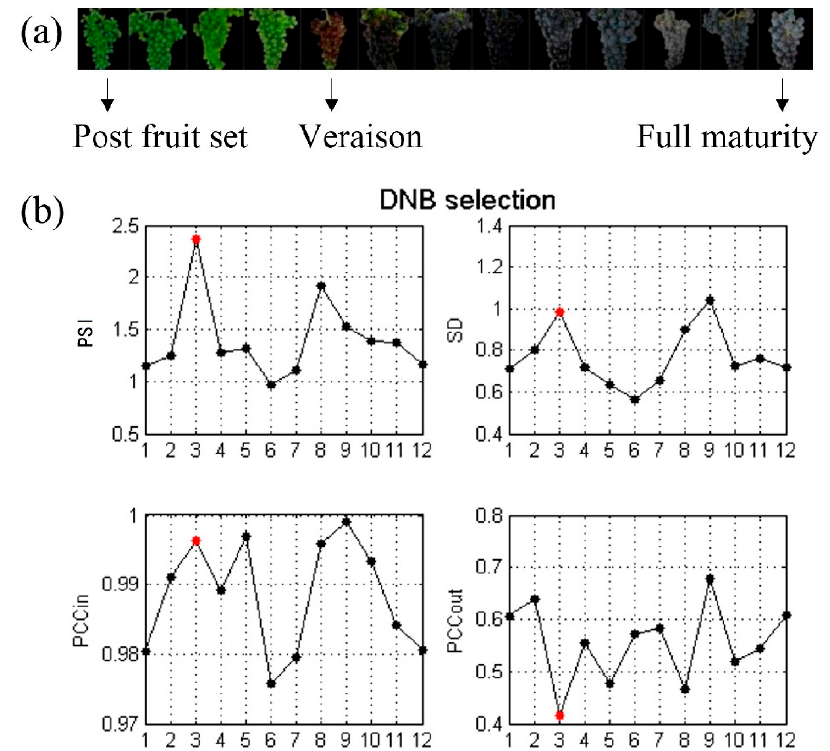
Figure 3. Grapevine berry ripening progress and comparison of gene modules with the highest comprehensive scores in each period. ( a ) The progress of grape berry ripening. ( b ) Dynamic changes inthe comprehensive index ofthe DNB module. The third time point with the maximum PSI index value was recognized as the critical transition point of grapevine berry ripening. The red point represents the tipping point of the systems.